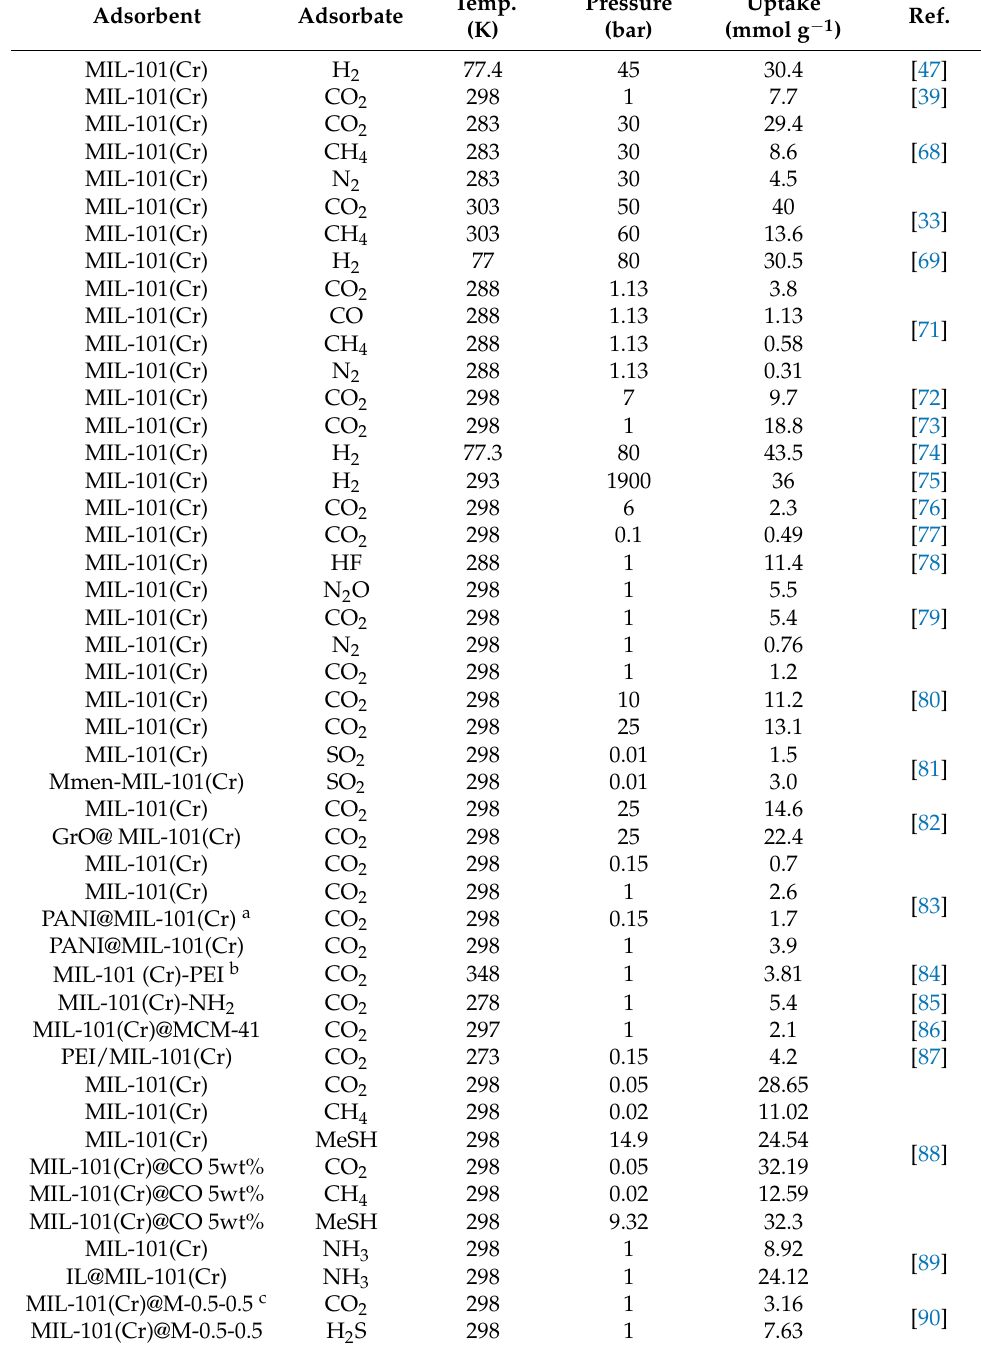
Table 2. Summary of gas adsorption for MIL-101(Cr) or its